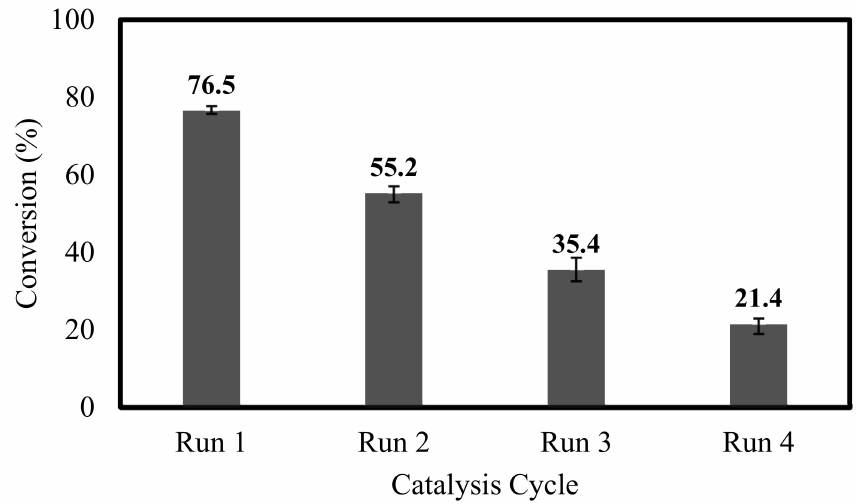
Figure 13. Catalyst recycling study of @PdCassCat catalyst. Reaction conditions: furfural (10 mmol), base (Et 3 N) (10 mmol), formic acid (20 mmol), temperature (160 ◦ C), time (24